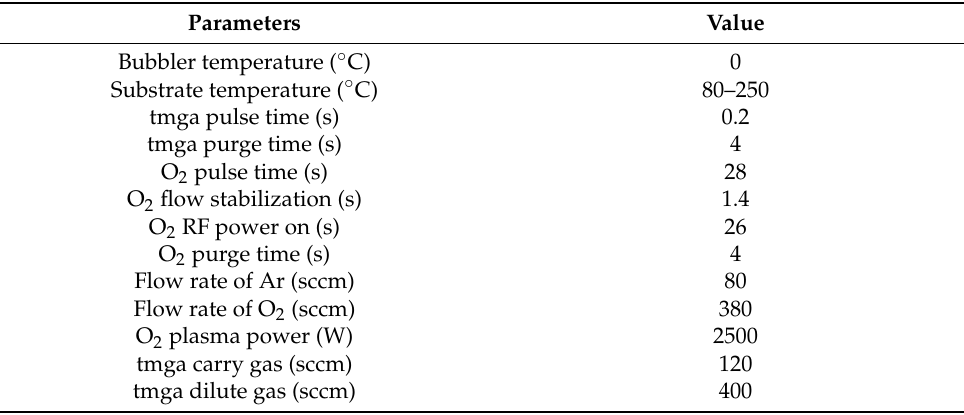
Table 1. Deposition conditions of PEALD Ga 2 O 3